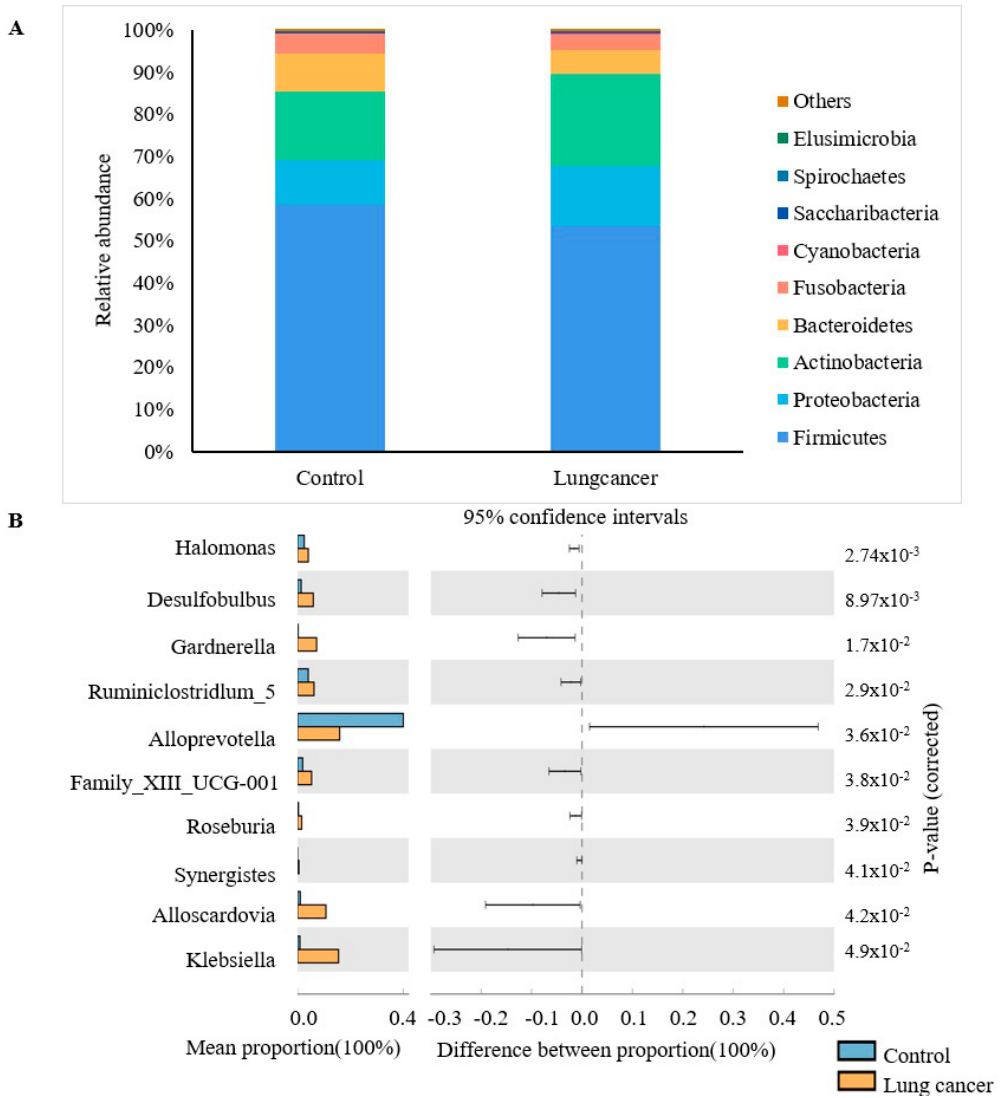
Figure 5. The differences in oral salivary flora between the control group and the lung cancer group. ( A ) At the phylum level, the human oral salivary flora is mainly Firmicutes, Proteobacteria, Actinobacteria, Bacteroidetes, and Fusobacteria , accounting for about 99% of the proportion. Compared with the control group, the proportion of Elusimicrobia in the lung cancer group decreased ( p = 0.038).